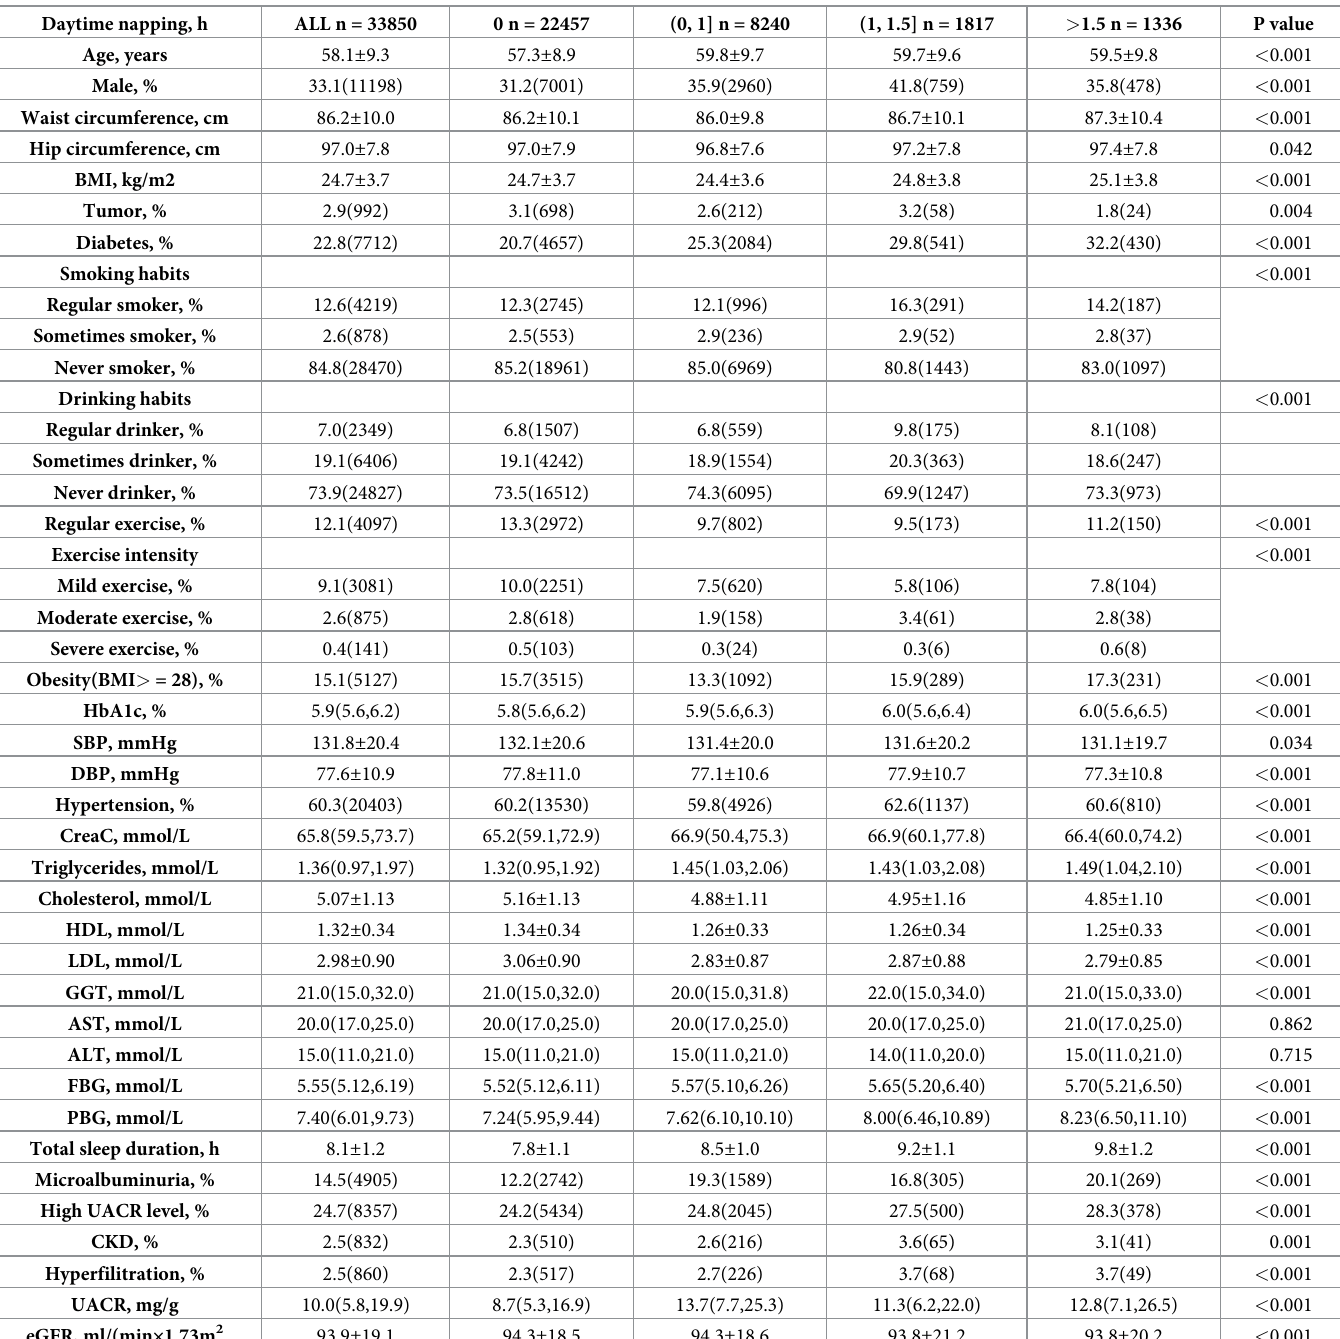
Table 2. Baseline information according to self-reported daytime